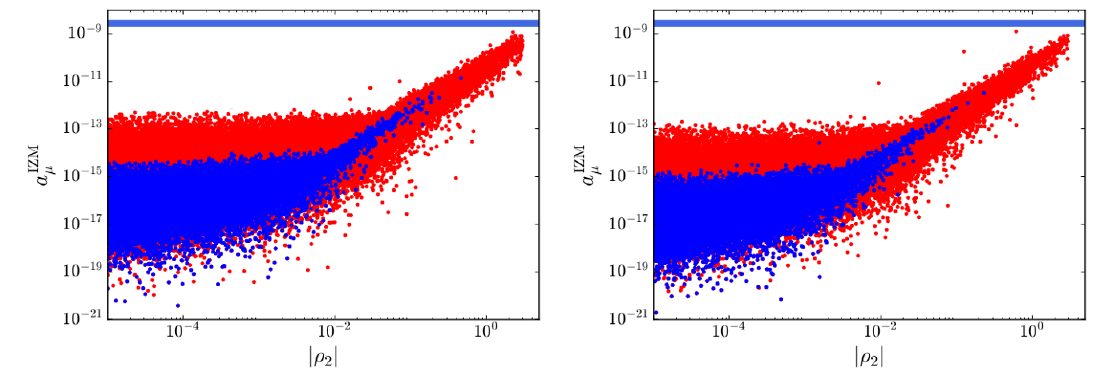
Figure 7 . The new contribution a IZM to the anomalous magnetic dipole moment of the muon as (cid:22) a function of j (cid:26) 2 j for NH (left panel) and IH (right panel). The horizontal blue band represents the discrepancy between the SM prediction and the experimental value